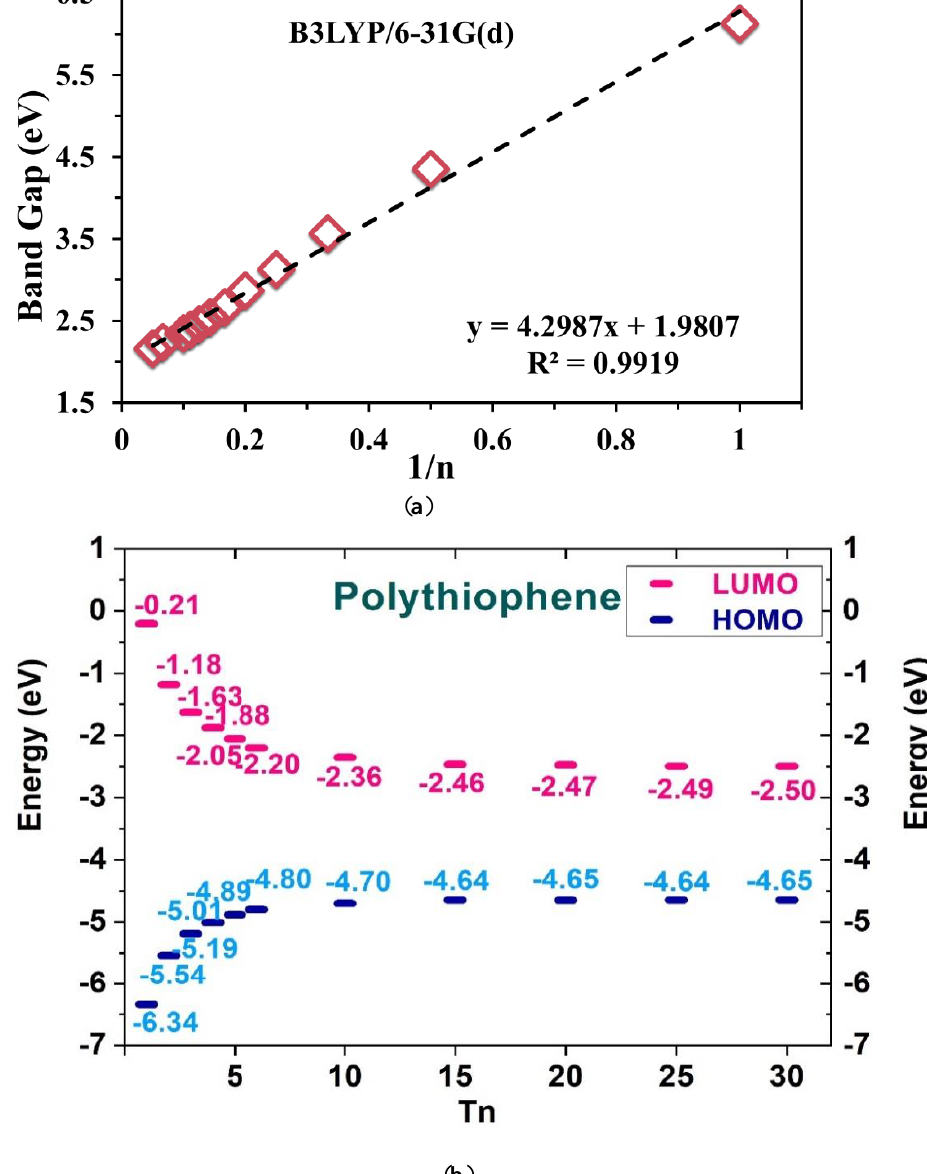
Figure 2. ( a ) Plot of band gap against 1/ n . A linear relationship was observed, and the data were fitted to y = ax + b; ( b ) HOMO and LUMO energy levels of T1, T10, T15, T20, T25, and T30 calculated using